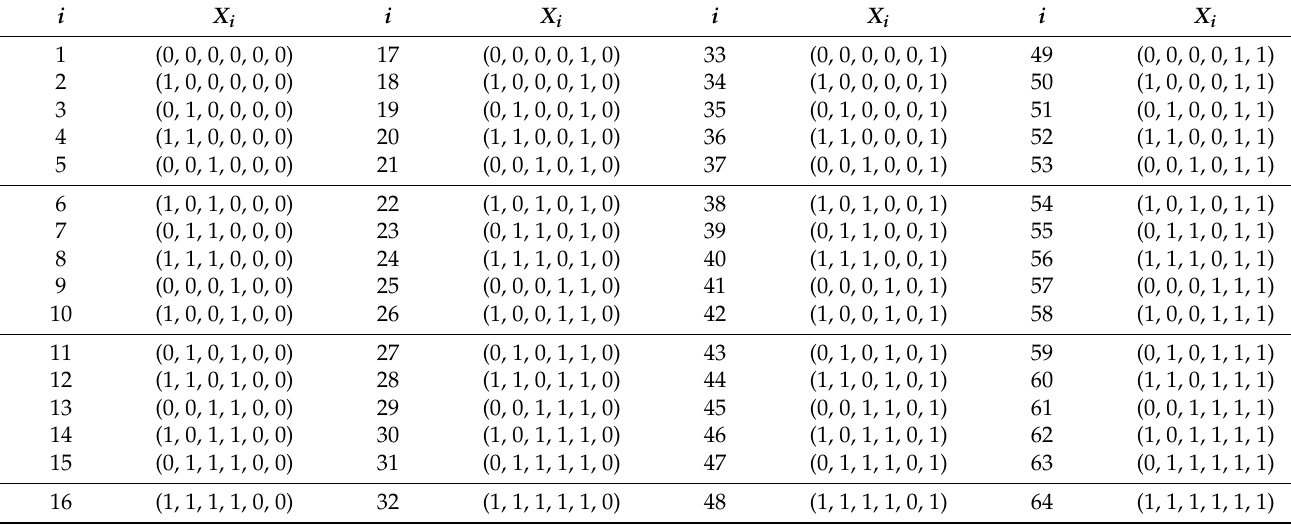
Table 2. Complete results obtained from the BAT in Figure 1.